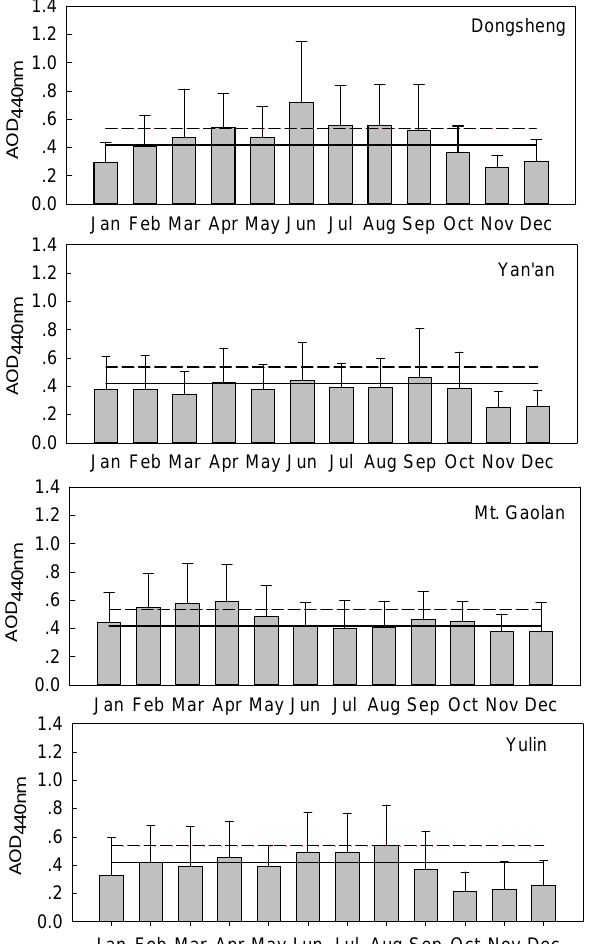
Figure 11. Monthly averaged AEs between 440 and 870nm at rural Loess Plateau sites. The solid and dash horizontal hairlines indi- cate the annual averages for the subgroup and the whole database,